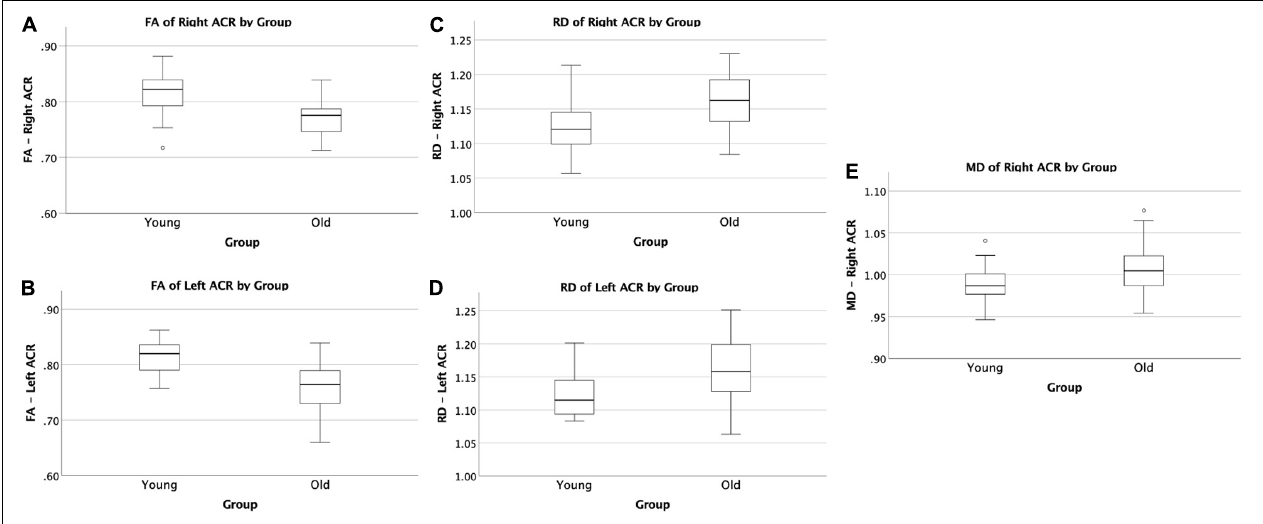
FIGURE 3 | Significant difference in ACR by group comparisons. (A) Boxplot showing significant reduction in FA in old adults compared to young adults on the right ACR. (B) Boxplot showing significant reduction in FA in old adults compared to young adults on the left ACR. (C) Boxplot showing significant increase in RD in old adults compared to young adults on the right ACR. (D) Boxplot showing significant increase in RD in old adults compared to young adults on the left ACR. (E) Boxplot showing significant increase in MD in old adults compared to young adults on the right ACR. All relationships are considered at p < 0.00083 (Bonferroni multiple comparison 0.05/60 labels) after controlling for sex and education. FA, fractional anisotropy; RD, radial diffusivity; MD, mean